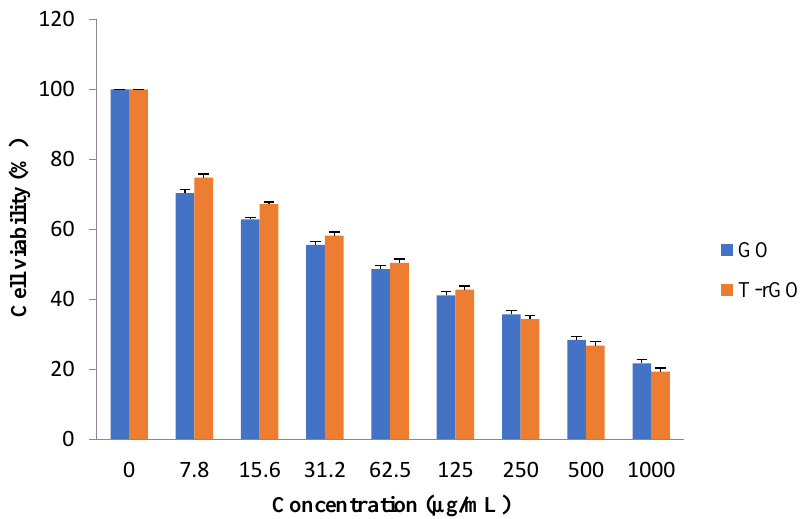
Figure 9. Effects of GO and T-rGO on cell viability of human lung cancer cells. The viability of human lung cancer cells (A549) was determined after 24 h exposure to different concentrations of GO and T-rGO using the WST-8 assay, (Mean ± SD).